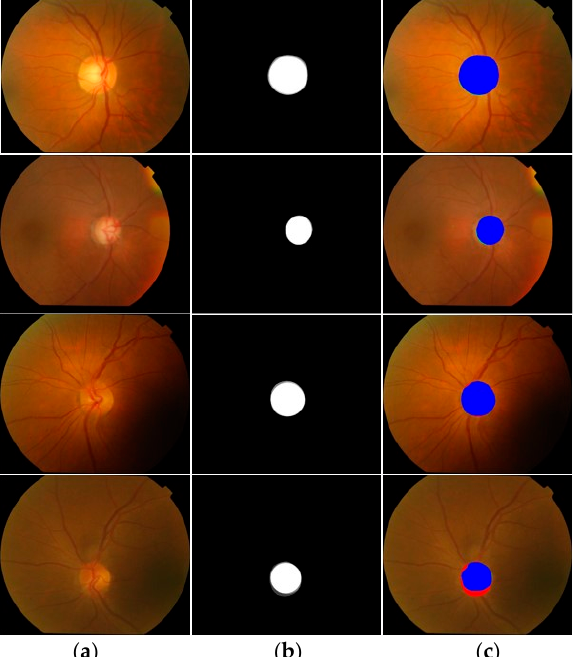
Figure 8. Good OD segmentation qualitative results on the Drishti-GS database, attained by applying FEDS-Net. ( a ) Input image, ( b ) corresponding groundtruth image, and ( c ) segmented output images (tp and fn pixels for OD are indicated in blue and red, respectively. Whereas, fp pixels are presented with green color) (Rows 1–3: good segmentation results; Row 4: poor segmentation result). In Table 2, quantitative results produced by FEDS-Net are compared with state-of-